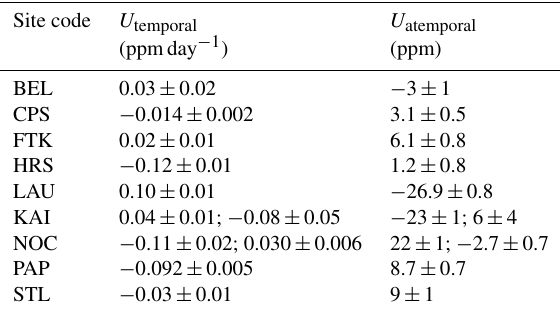
Table 3. Results from drift- and bias-correction analysis at sites for which at least 3 months of observations are available for comparison with the ELC BEACO 2 N